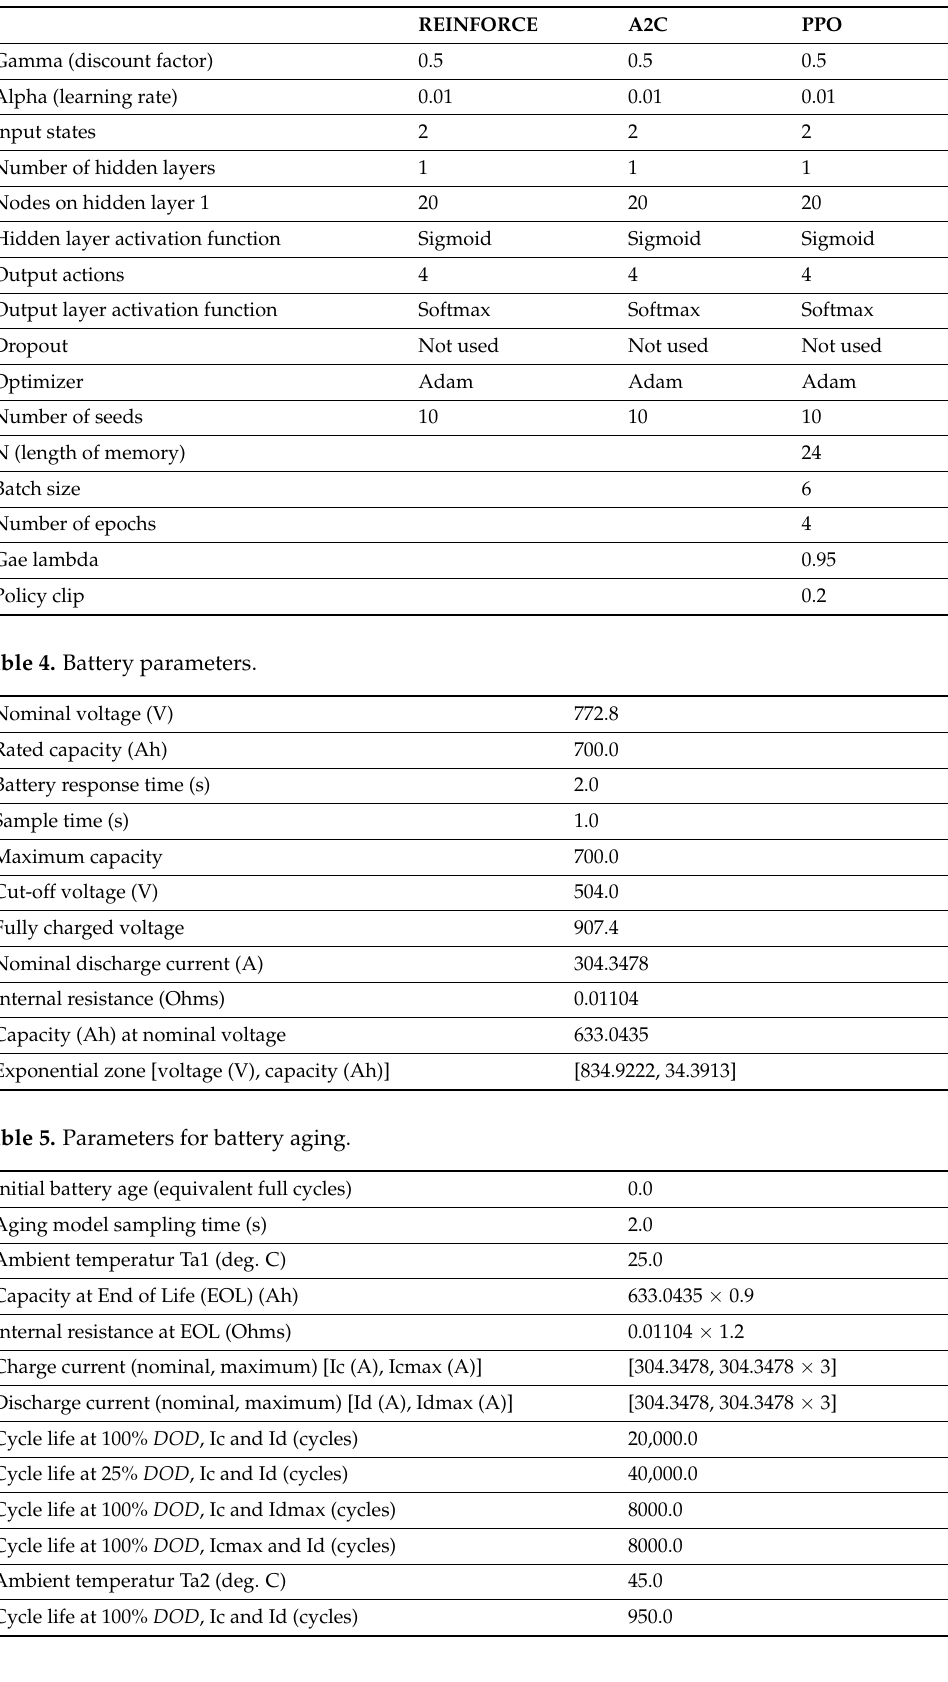
Table 3. Parameters for training and validation.